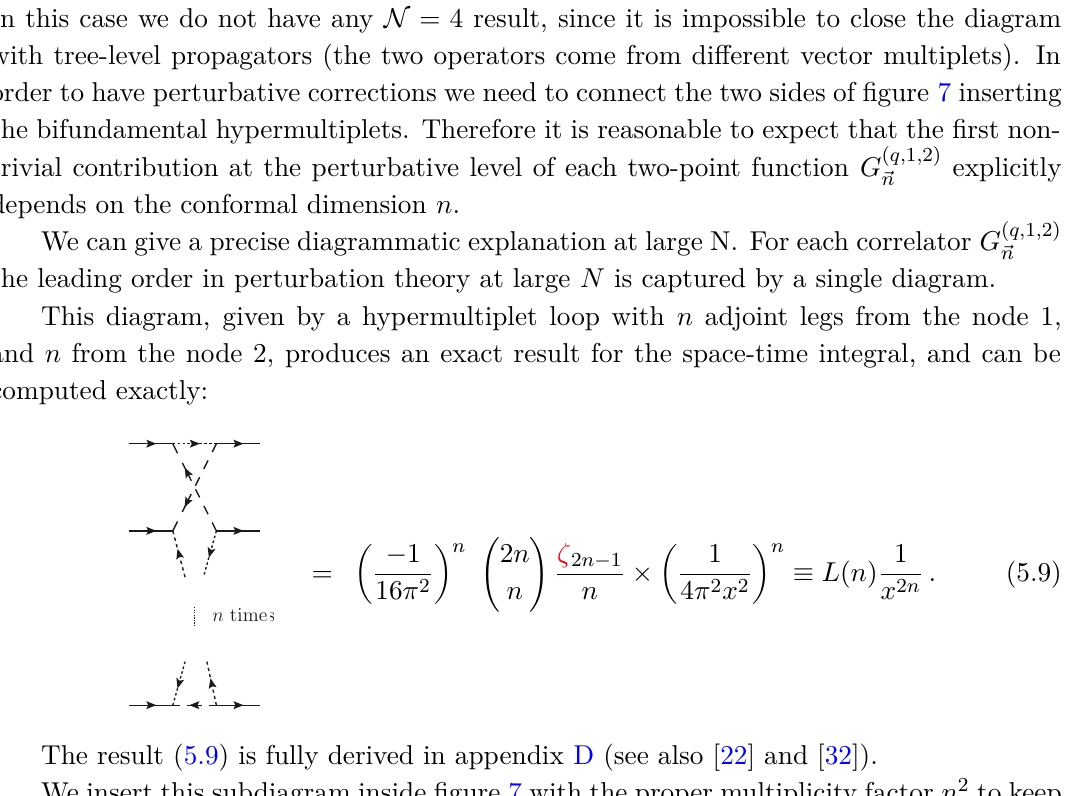
Figure 8. Leading and Next-to-Leading Orders for G ( q, 1 , 2) correcting the legs of both nodes 1 and 2 with the vector